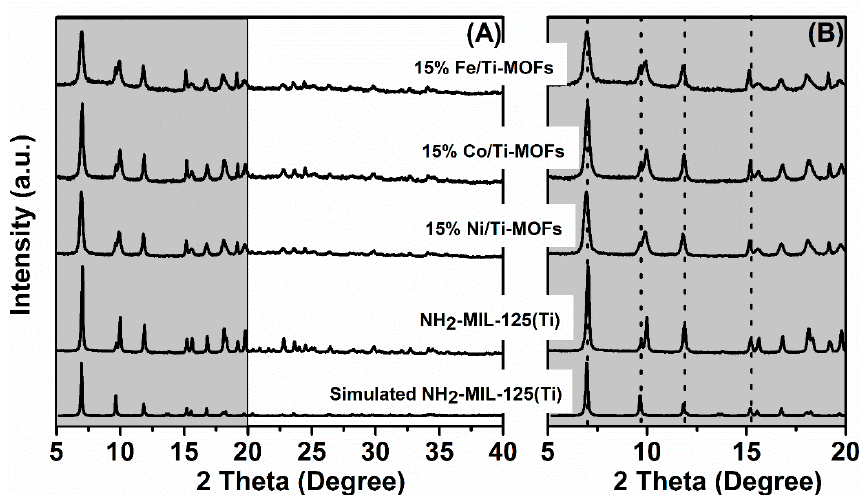
Figure 1. XRD parterns of NH 2 -MIL-125(Ti) and 15% M/Ti-MOFs (M: Ni, Co, Fe): ( A ): the 2 θ range of 5–40° ( B ): the 2 θ range of 5–20°.